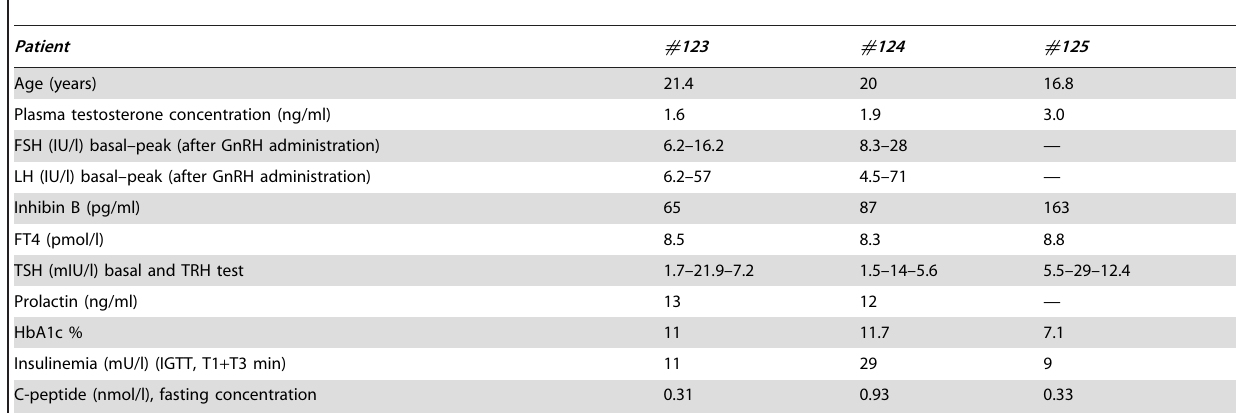
Table 2. Hormonal status of the three affected